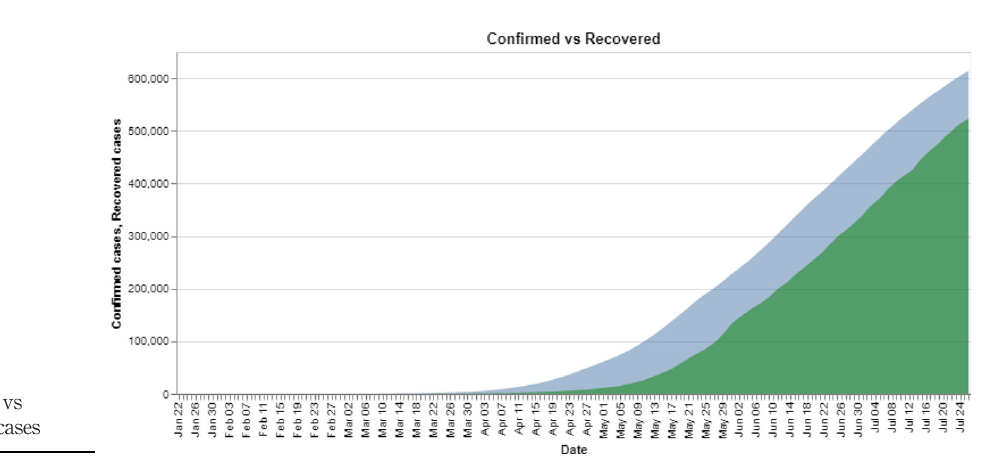
Figure 4. Con fi rmed vs recovered